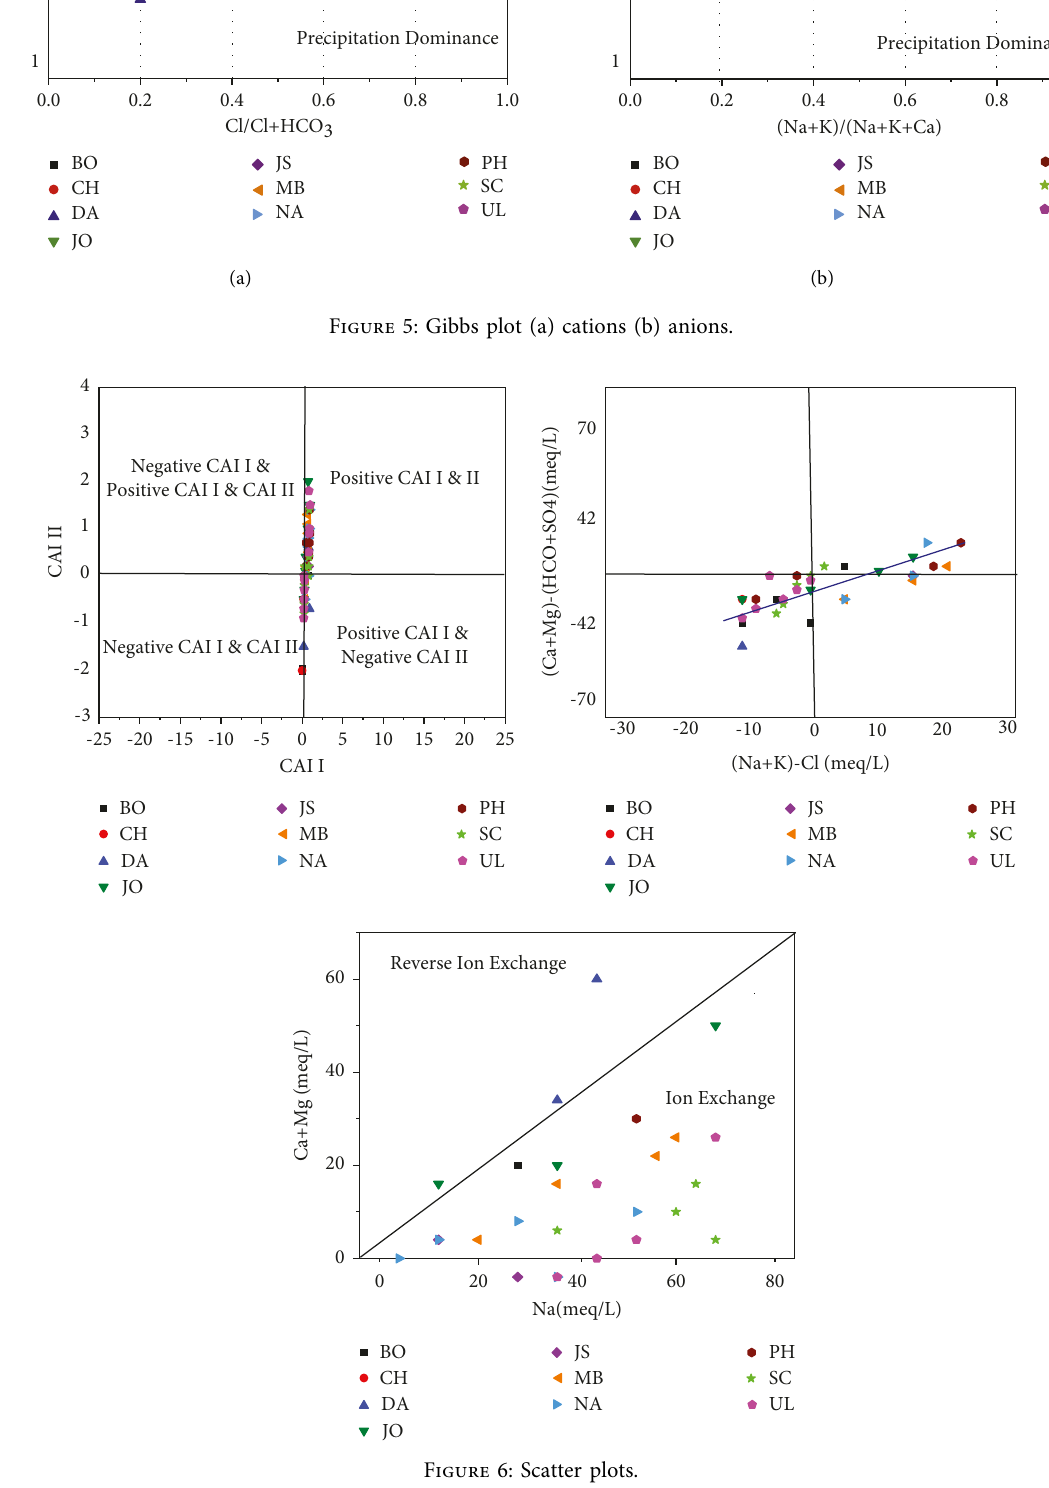
Figure 6: Scatter